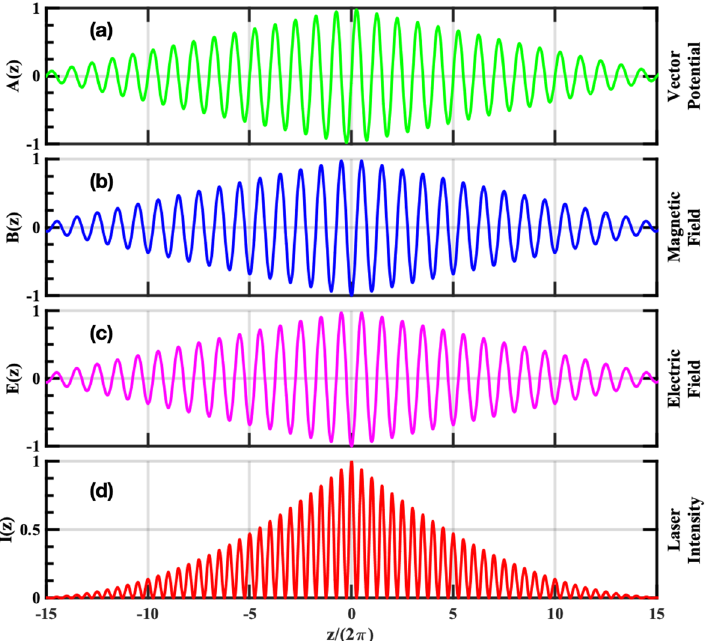
Figure 2. In this schematic diagram the ( a )–( d ), respectively represent the variation of the vector potential, magnetic field, electric field and intensity of the laser with respect to the z-coordinate. The figures show that the 0 ) and decreases on either side of laser fields and laser intensity are maximum at the focal point ( z = 1 and ε 0.03 . In this schematic diagram, the sub-figures (a)–(d) respectively represent the variation of a 0 = ∼ 30 cycles of the laser period. The vector potential, magnetic field, electric field and intensity of the laser over ∼ 0 ) and decreases on either side of the focal point. laser field is maximum at the focal point ( z = 0 ), intense, We now present results obtained for a charged particle interacting with a linearly polarized ( δ = 4 ). The intensity of the wave at the focal 10 focused wave train (for our numerical work, we have chosen ε − ∼ 8 (for a 1 µ wavelength laser). For our 1000 ( 1.8 10 10 24 W / cm 2 ), and τ 0 point is chosen to be a 0 − = ≈ × ∼ numerical work, we have used three sets of initial conditions. For the first two sets, the initial conditions are chosen in such a way that the inequality given by Eq. (16) is satisfied. For these two sets, the particle is assumed 9500 and z 9869 with a ( z 0 ) 0 ) and, from initial positions z 0 50 and to start from rest ( p 0 = − = − = = 13.1 respectively. For both these sets, the phase of the wave initially seen by the particle is chosen such a ( z 0 ) = 0 ). For these initial conditions that the perpendicular canonical momentum vanishes (i.e. � P 0 = ⊥ 885.3 < a 0 and a 62.7 < a 0 respectively; thus for both these cases, as per Eq. (16) it is expected that a z z ref ∼ ref ∼ during the motion, the parameter (cid:31) , will become complex and the particle will eventually reflect from the high intensity region. The basic difference between the above two sets is that, near the reflection point, in the first case 12 > 1 , whereas in the second case it is radiation reaction force dominates over the Lorentz force i.e. τ 0 a 3 z ref ∼ 3 << 1 . For the third set, the choice of initial conditions is such that 4 10 the other way around i.e. τ 0 a 3 z − × ref ∼ the above mentioned inequality (Eq. (16)) is violated. For this set, the particle is assumed to start from rest 9450 , which is now placed closer to the focal point than that in the 0 ), from the initial position z 0 p ( � = − = previous cases. As before, the phase of the wave initially seen by the particle is chosen in such a way that the 0 ) and a ( z 55 . For these initial conditions and for perpendicular canonical momentum vanishes (i.e. � P 0 0 ) = = ⊥ 1070.9 > a 0 ; thus as per Eq. (16), the parameter (cid:31) will remain the same laser and focusing parameters, a z ref ∼ real throughout the motion and the particle is expected to pass through the focal point. For the first set of initial conditions, the numerical results are presented in Figs. 3 and 4. In Fig. 3a–d respec- tively represent the longitudinal ( p z ) and transverse ( p y ) component of particle momentum, the energy and the parameter (cid:31) ; and Fig. 4 represents the trajectory of the particle. We first discuss the particle dynamics in the absence of radiation reaction effects. In Figs. 3a–c and 4, the red and green curves, respectively represent the forward and the reflected motion of the particle in the absence of radiation reaction effects (values correspond to y-axis on the left). The red curves in Fig. 3a and b respectively show that as the particle approaches the focal point (increasing a ), the average longitudinal momentum decreases monotonically and approaches zero, whereas the amplitude of the transverse momentum simultaneously increases. After reflection (represented by the green curves), as the particle moves away from the focal point (decreasing a ), the absolute value of average longitudinal momentum increases and the particle leaves the focal region with a finite value of longitudinal momentum in the opposite direction, whereas the amplitude of the transverse momentum decreases and eventually goes to zero. These numerical results are respectively in conformity with Eqs. (12) and (9). The corresponding energy is shown in Fig. 3c, which shows that for our choice of parameters the average energy which remains with the particle after 0.3 GeV ). It is to be noted that the average energy does not change throughout 600 ( reflection is around γ ∼ ∼